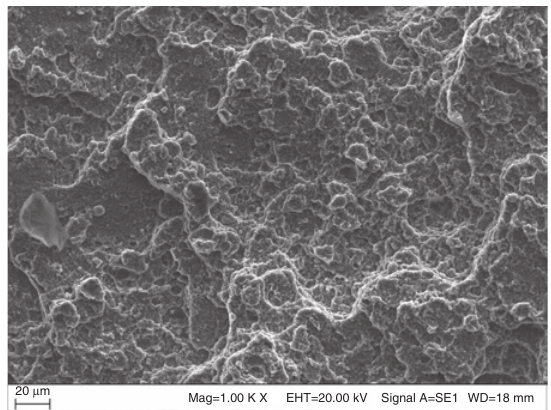
Figure 18 SEM image of the fracture surface of the N7